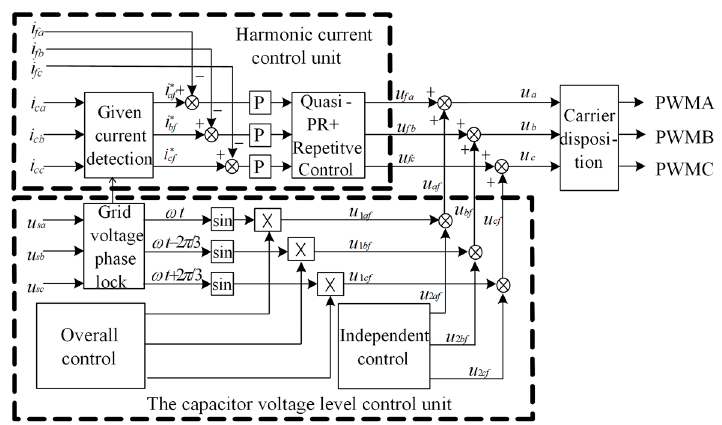
Figure 2. The overall control structure of the new APF system.